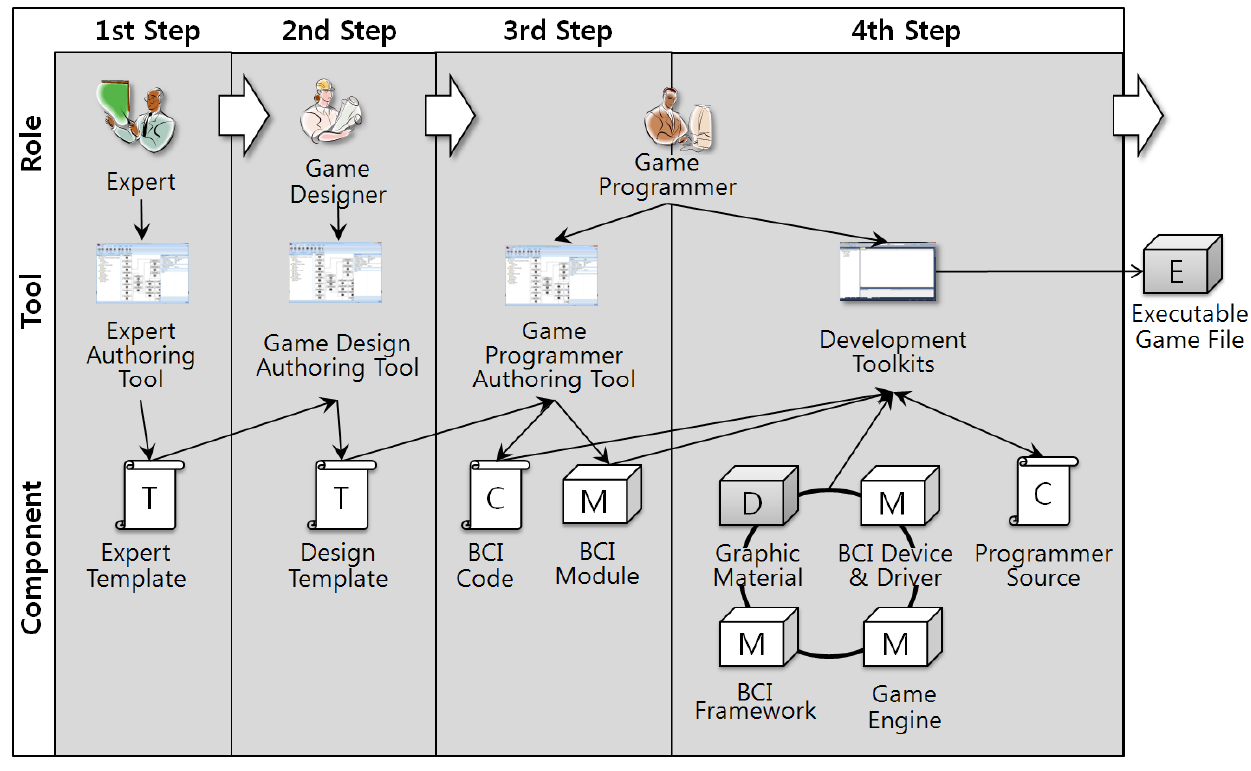
Figure 3. Relationships between Developers, Authoring Tools, and Outputs. There are three kinds of authoring tool that generate diverse